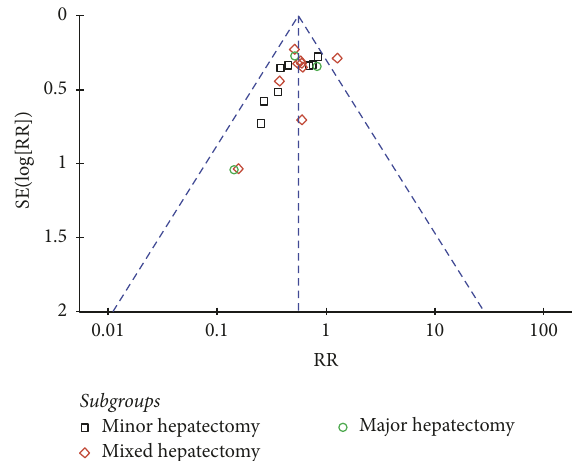
Figure 5: Funnel plot of the overall postoperative